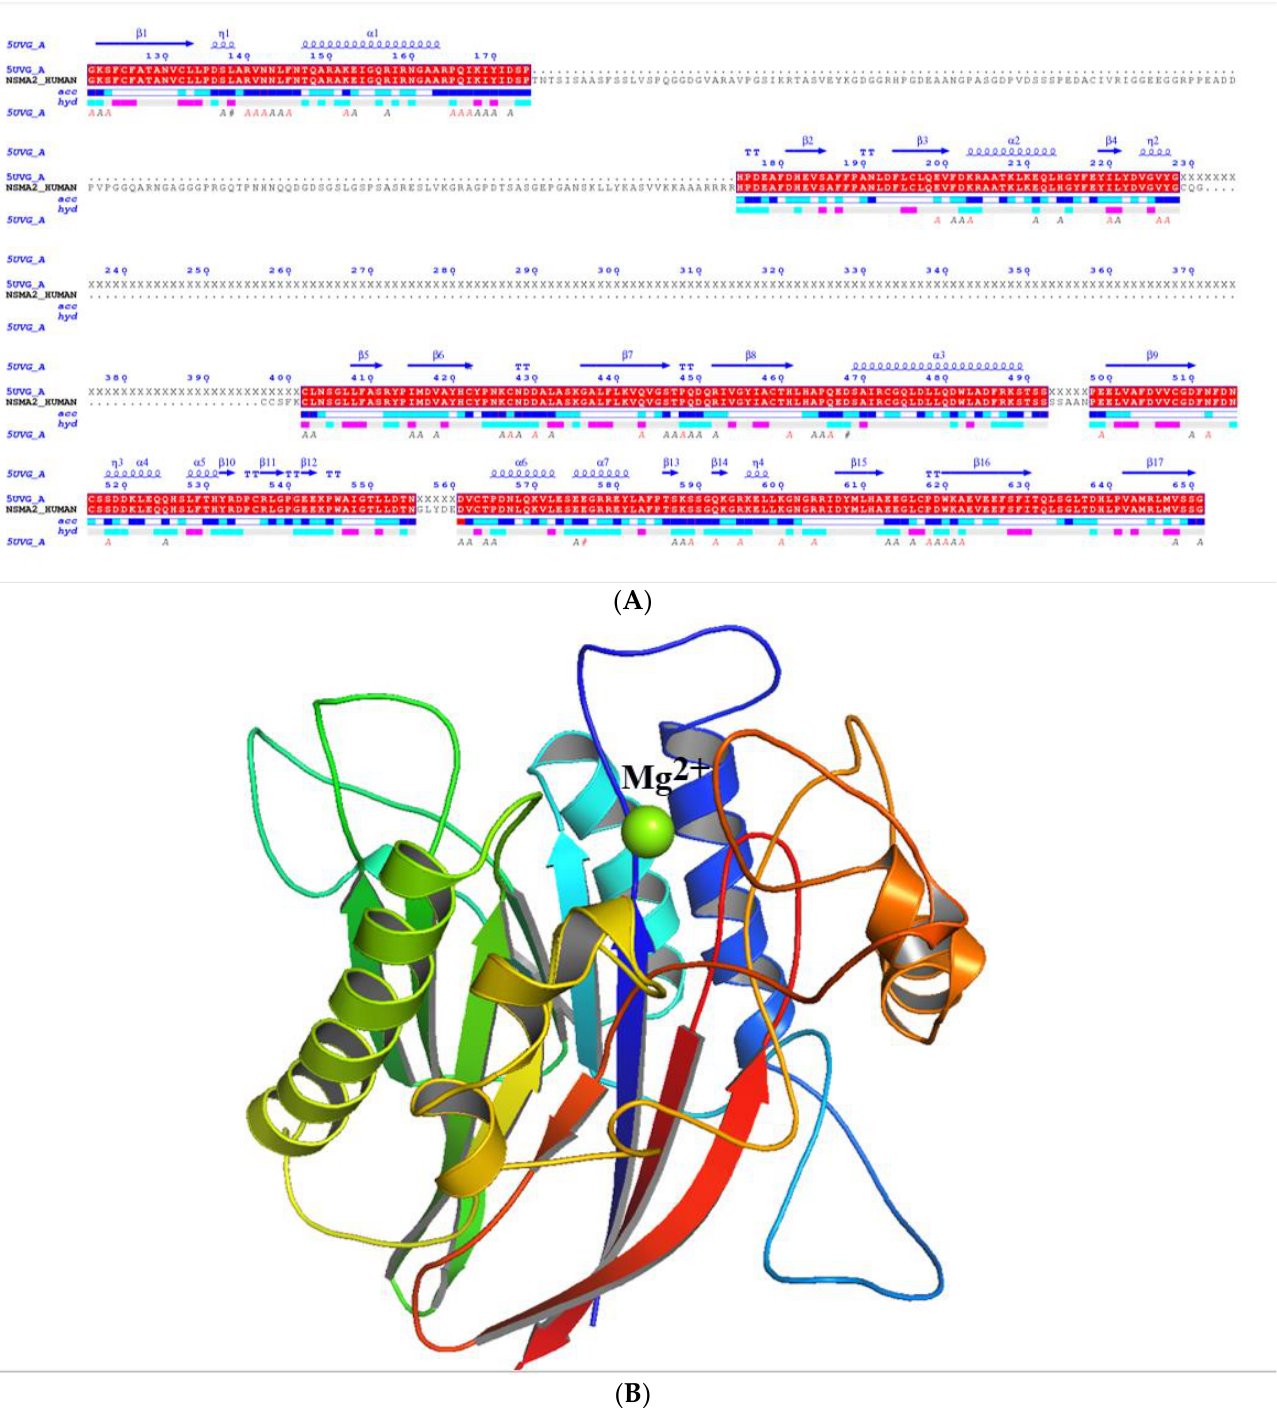
Figure 1. nSMase2 structure preparation. ( A ) Sequence alignment of the amino acid sequence from PDBId:5UVG and the sequence of hSMAse2 with EndScript2 [21], applying EMBOSS Water with the Smith-Waterman algorithm using standard parameters. Identical residues are highlighted in red. ( B ) Ribbon representation of the 3D model of human nSMase2 catalytic domain with Mg 2+ (green sphere) in the active site and the protein colored in N-to-C mode (blue-to-red).